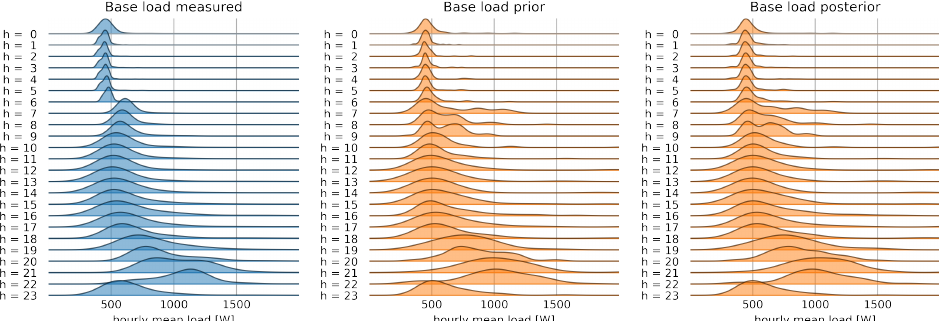
Figure 3. Ridgeline plot of distribution of the measured base hourly load, and of its prior and posterior distributions, grouped by the hour of the